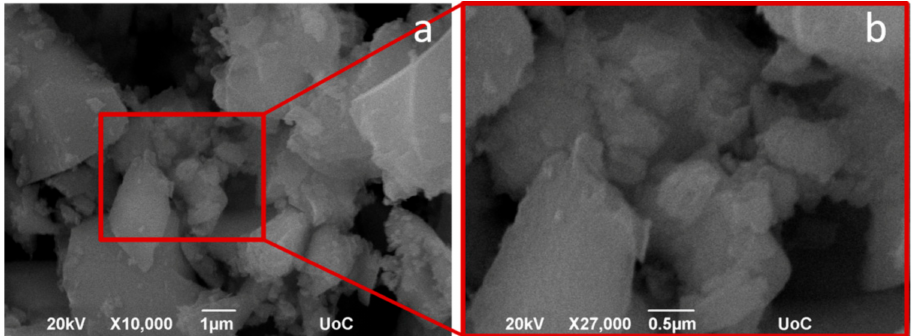
Figure 6. SEM images of pure TiO 2 : ( a ) image captured from random area; ( b ) magnified images of the area selected at ( a